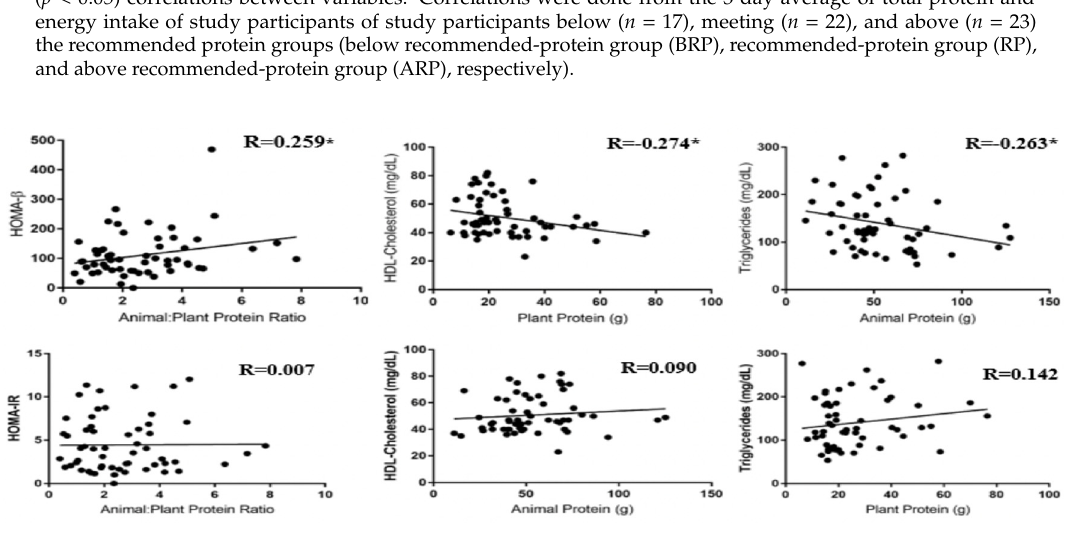
Figure 4. Correlations between homeostatic model assessment for insulin resistance (HOMA-IR) and homeostatic model assessment for beta-cell function (HOMA- β ) with animal-to-plant protein ratio; HDL (high-density lipoprotein) cholesterol with animal and plant protein; triglycerides with animal and plant protein ( n = 62). Values are reported as Pearson correlation coefficient (r). * Denotes significant differences among groups ( p ≤ 0.05).